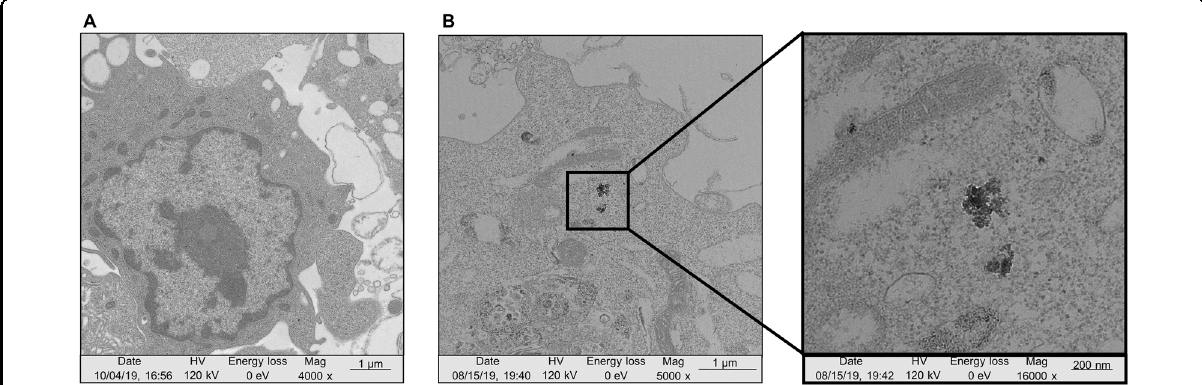
Fig. 3 Transmission electron micrographs of RAW264.7 cells. The samples were ( A ) untreated and ( B ) treated with 200 nM AfFtnAA for 24 h. Scale bars are 1 μ m (magni fi ed image scale bar is 200